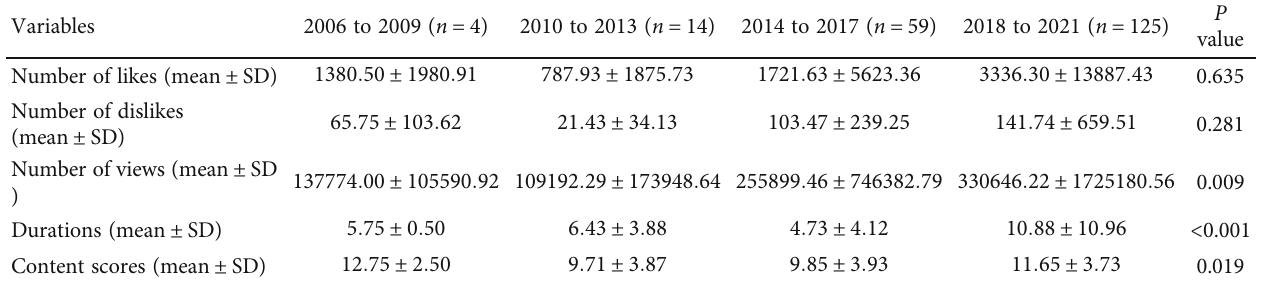
Table 9: Analysis of variables in relation years of YouTube content release on hydroponic